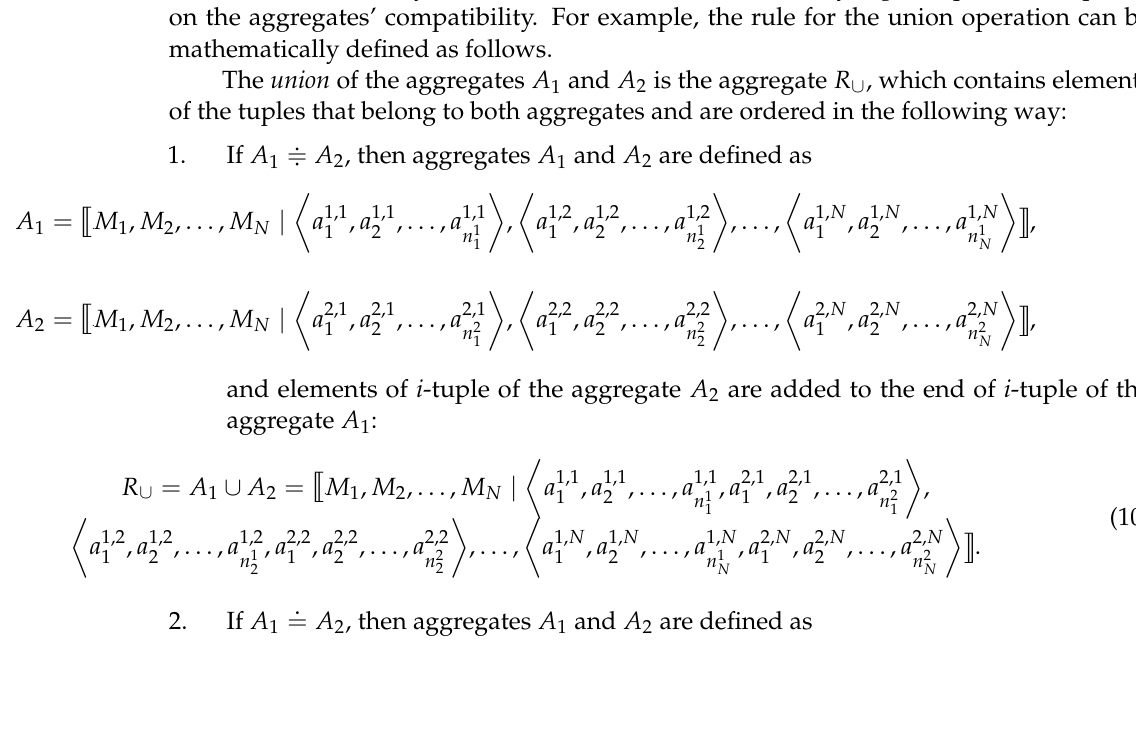
Figure 3. An example of two incompatible aggregates. Figure 1. An example of two compatible aggregates. Figure 1. An example of two compatible aggregates.